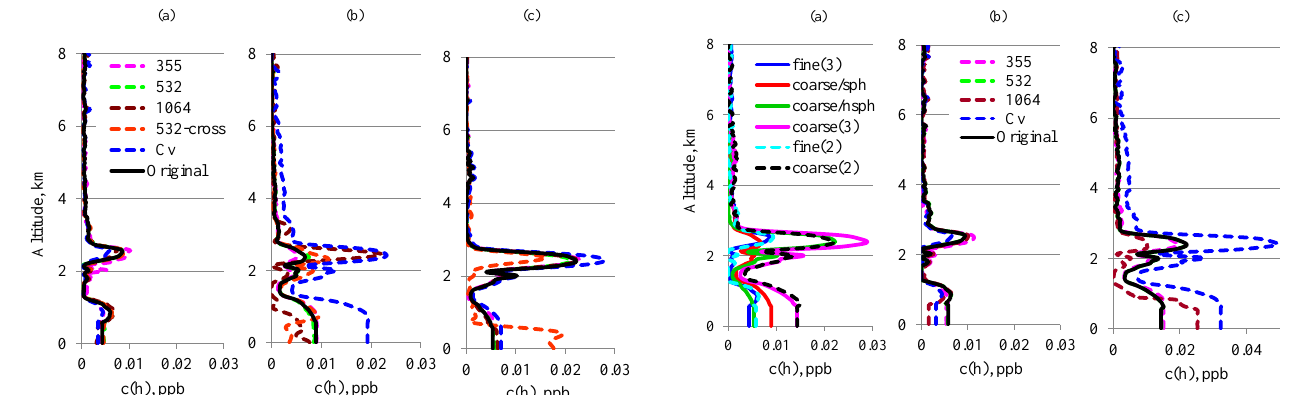
Figure 11. Variation of aerosol concentration profiles, c k (h) , for fine (a) , coarse spherical (b) and coarse non-spherical (c) aerosol modes in response to elimination of different parts of input informa- tion. Tag “Original” denotes complete set of input data; tag “355” (or 532, 1064, 532-cross) denotes that lidar signal at 355nm (or 532, 1064, 532-cross) wavelength is excluded; tag “ C V “ denotes that columnar volume concentrations of aerosol modes are excluded.